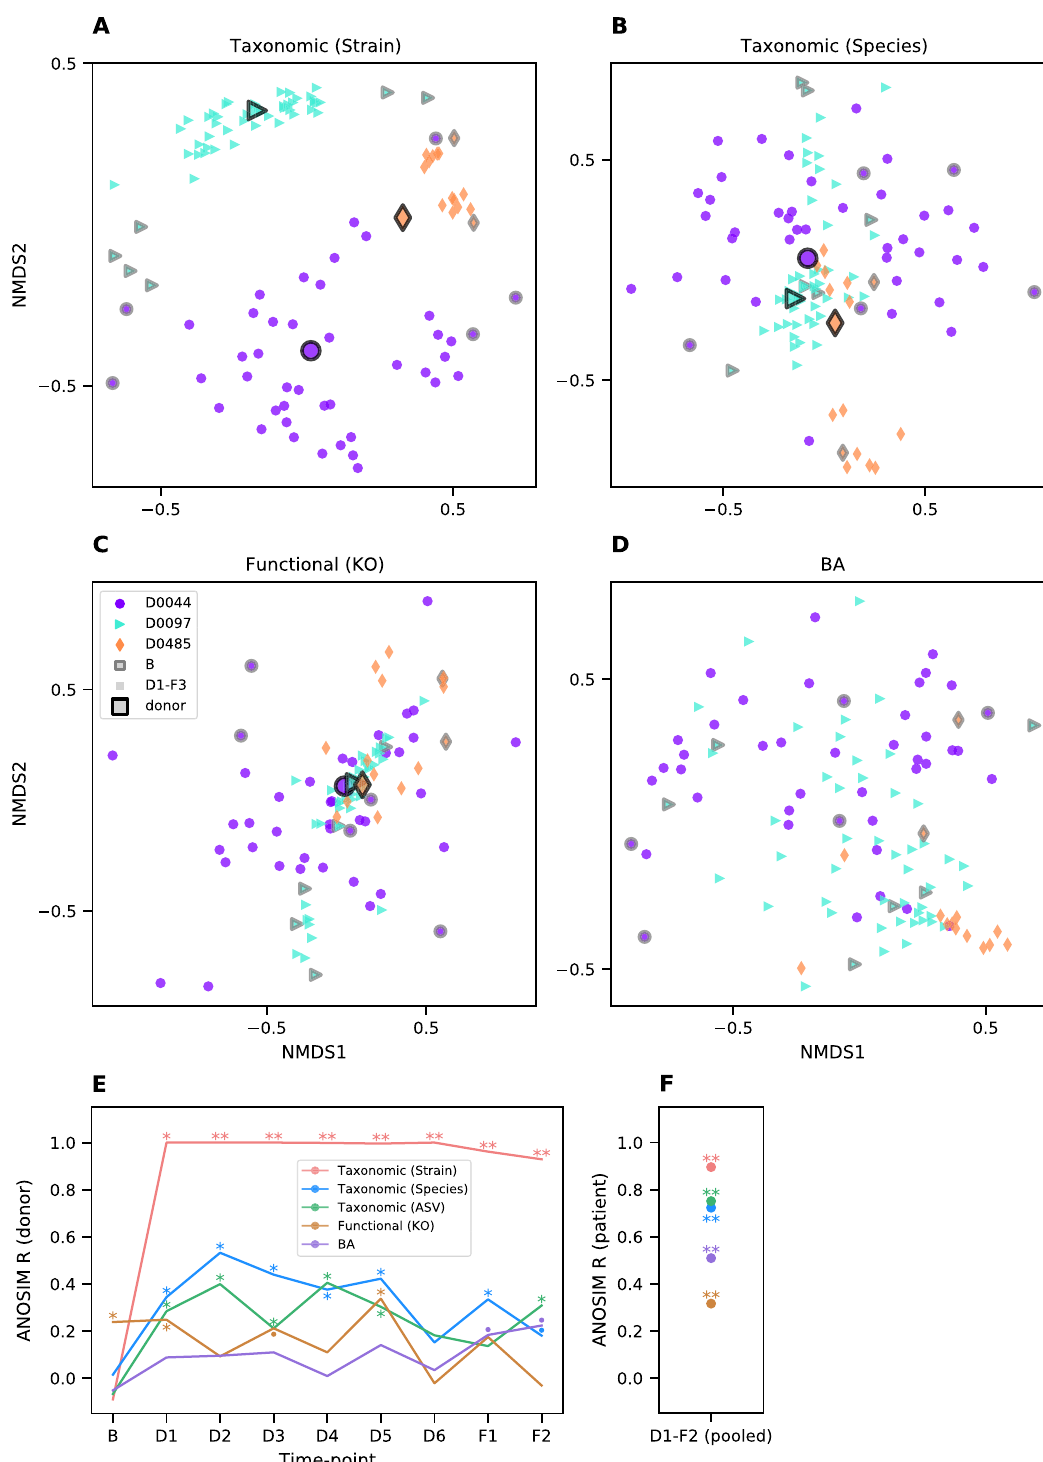
Figure 2. Samples cluster within patient and donor groups during and after FMT treatment. (A–D) Non-metric multidimensional scalings were calculated from pairwise sample comparisons based on BC dissimilarity of taxonomic profiles from shotgun metagenomes at strain (A) , and species resolution (B) , and on cosine dissimilarity of functional gene (C) and BA profiles (D) . The orientations and scales of axes are arbitrary, and proximity on a plot reflects similarity. Markers represent individual fecal samples from patients (no black outline) or the mean of all samples from a single donor (black outlines). Shapes and colors are matched between patients and their respective donors. Patients’ baseline samples are outlined in grey. Identical ordinations colored by individual subjects are available in Supplementary Fig. S1. (E,F) ANOSIM R scores, an index of clustering strength based on pairwise sample dissimilarities, for the four profiles from (A–D) as well as an additional taxonomic profile based on 16S rRNA gene ASVs. Larger R values indicate stronger clustering by donor at each time point (E) or by patient across pooled time points (F) . Significance, as assessed by ANOSIM permutation test (n = 9999): p ≤ 0.1 ( ▪ ), p ≤ 0.05 (*), p ≤ 0.001